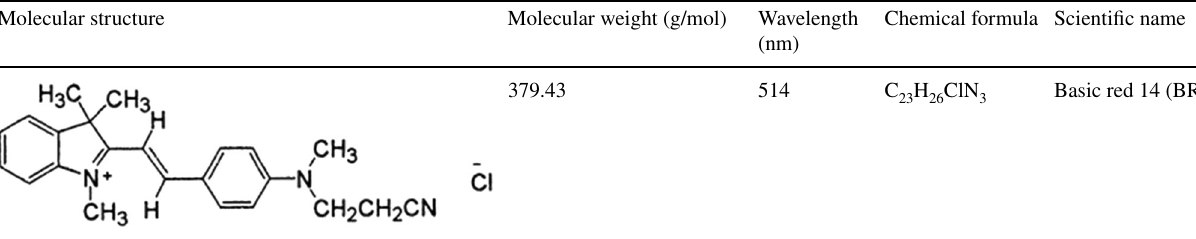
Table 1 Properties and chemical structure of the cationic red 14 dye Molecular